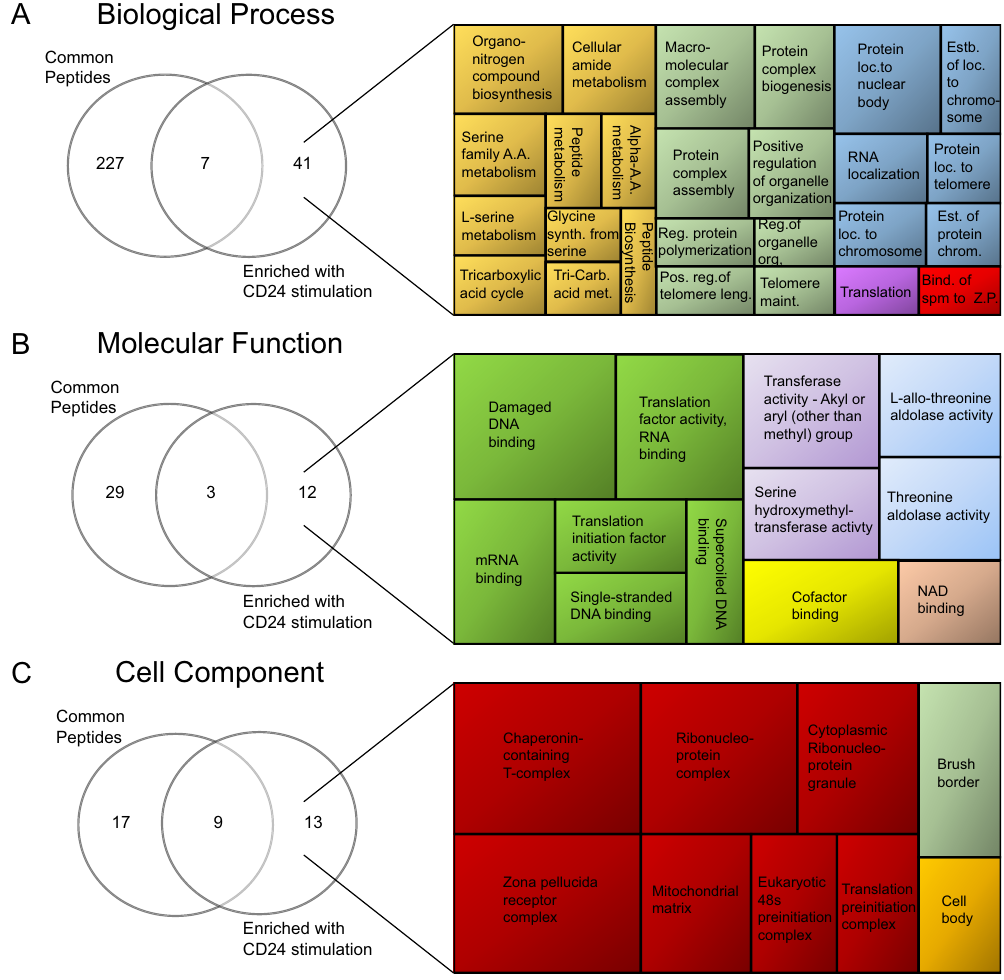
Figure 3. Proteomics analysis suggests that CD24 stimulation causes enrichment of proteins from specific functional categories into MVs. Gene Ontology (GO) enrichment analysis was performed on proteins common to MVs from all 6 isotype and anti-CD24 samples in comparison to the proteins enriched in MVs after 1 h anti-CD24 stimulation (Supplemental File 1). Venn diagrams (left panels) show GO terms associated with all MVs or those associated with the proteins enriched in MVs after anti-CD24 stimulation. The numbers indicate the number of unique GO terms associated with the respective protein lists. Enriched GO terms were visualized by Revigo 70 (right panels). ( A ) CD24-enriched biological process (BP): Cellular amide metabolism (yellow), macromolecular complex assembly (green) and protein localization to nuclear body (blue). ( B ) CD24-enriched molecular functions (MF): Damaged DNA binding (green), transferase activity (purple) and threonine aldolase activity (blue). ( C ) CD24-enriched cellular component annotations were primarily grouped as chaperonin- containing T-complex (red). A.A. = amino acid, Synth = synthesis, Carb = carboxylic, Reg = regulation, Pos. = positive, Leng. = length, org = organization, Maint = maintenance, Loc = localization, Est = Establishment, Spm = sperm, Z.P = zona